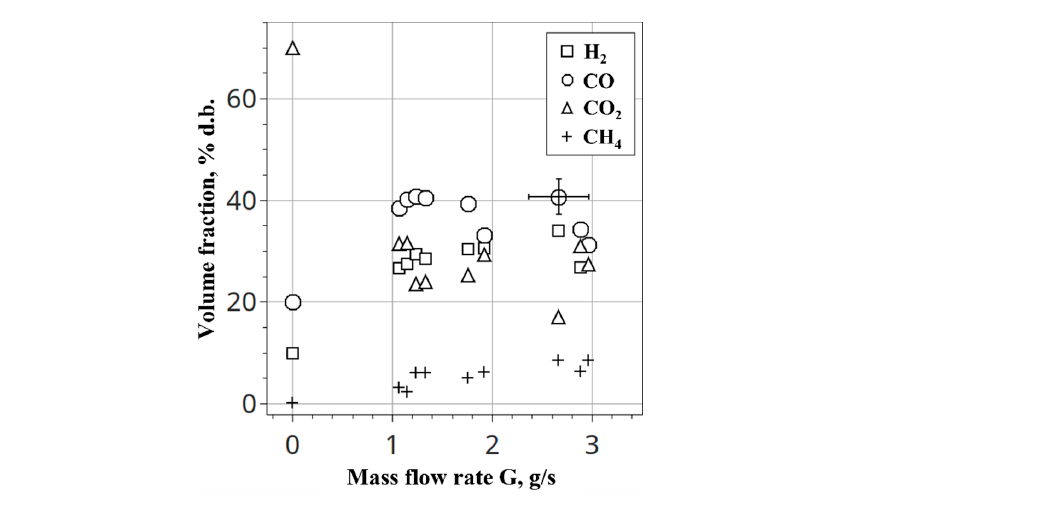
Figure 11. Measured composition of cooled dry products of liquid waste gasification versus the mass flow rate of waste ( f = 1 Hz, P ≈ 0.1 MPa). Measurement errors are shown only for the near-limiting value of G .